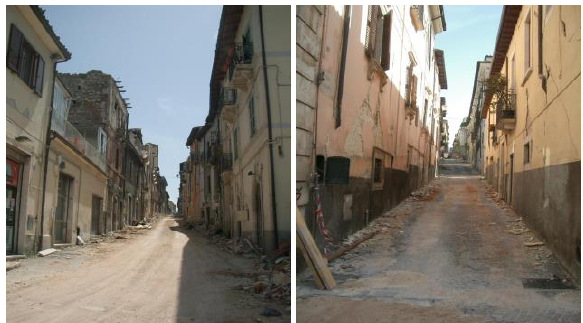
Figure 1. On the left Via Roma, on the right Via Cascina (2009)